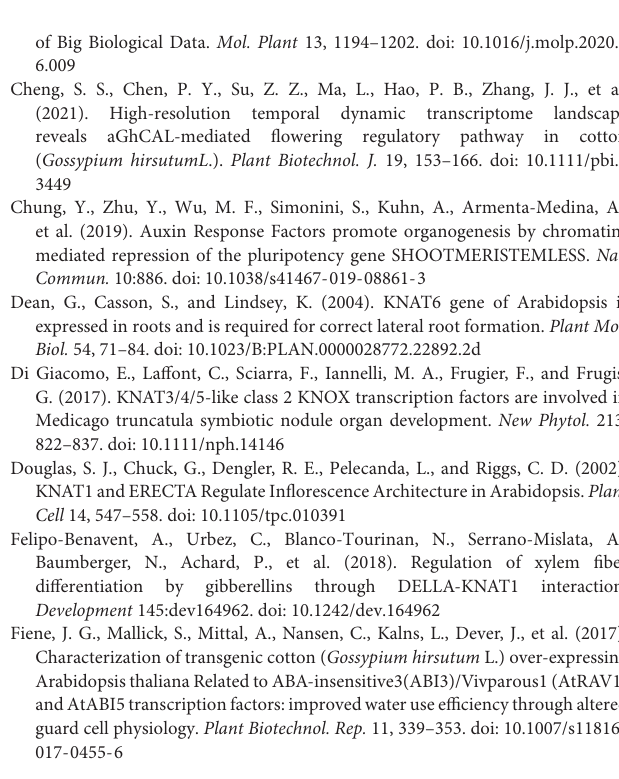
Supplementary Figure 1 | Distribution of G . hirsutum KNOX protein motifs. The different-colored boxes represent the conserved motifs containing KNOXI (green), KNOXII (purple), ELK (cyan-blue), and homeobox KN (red) binding domains. Supplementary Figure 2 | Amino acid sequences showing the highly conserved KNOX domains in Arabidopsis (A) and G . hirsutum (B) . Supplementary Figure 3 | Expression profiles of GhKNOX genes at different stages of shoot meristem development in the G. hirsutum cultivars ‘Zao1’ and ‘CCRI50.’ Shoot apical buds were harvested at the fourth leaf expanded to the seventh leaf expanded stages. Colors from red to green represent expression levels ranging from high to low, respectively. Supplementary Figure 4 | Expression analysis of five G . hirsutum KNOX genes in the VIGS assay. (A) Phenotype of the positive control plant transformed with the pCLCrVA-PDS vector. (B) Relative expression levels in empty control (TRV:00) and five GhKNOX genes VIGS plants. The five GhKNOX genes were GhKNOX2-A , GhKNOX10-A , GhKNOX14-A , GhSTM2-A , and GhSTM3-A/D , respectively. Supplementary Table 1 | PCR primers used in the